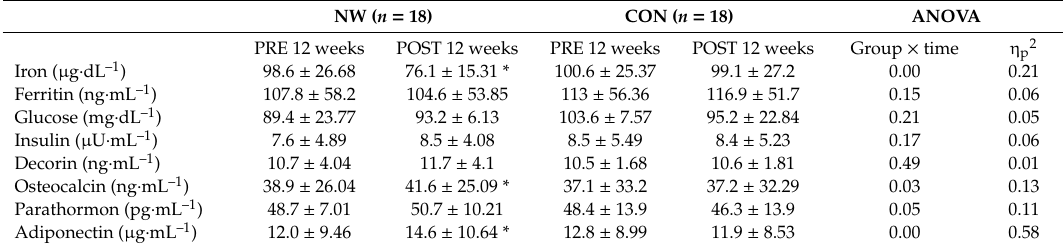
Table 4. Changes in iron metabolism, exerkines, and myokines